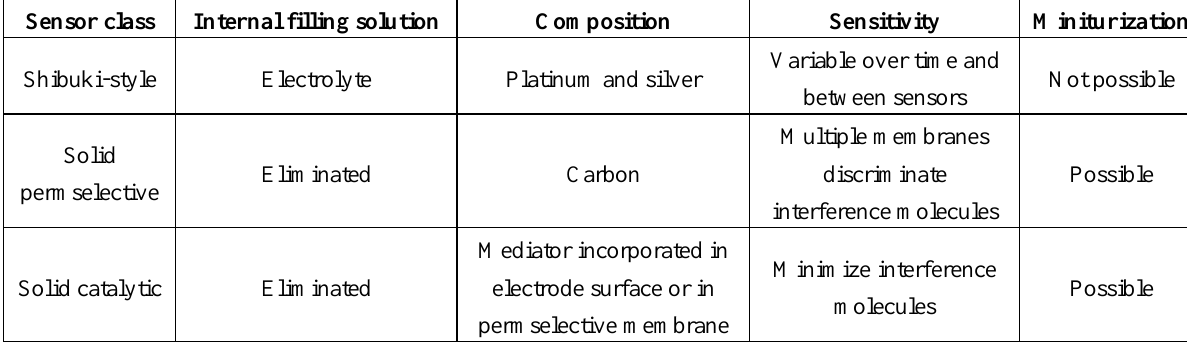
Table 1. Characteristics and composition of nitric oxide